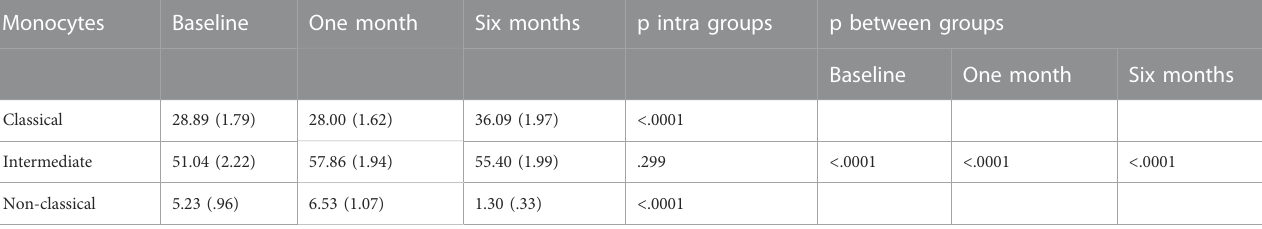
TABLE 3 Percentage of monocyte subtypes, throughout the study.